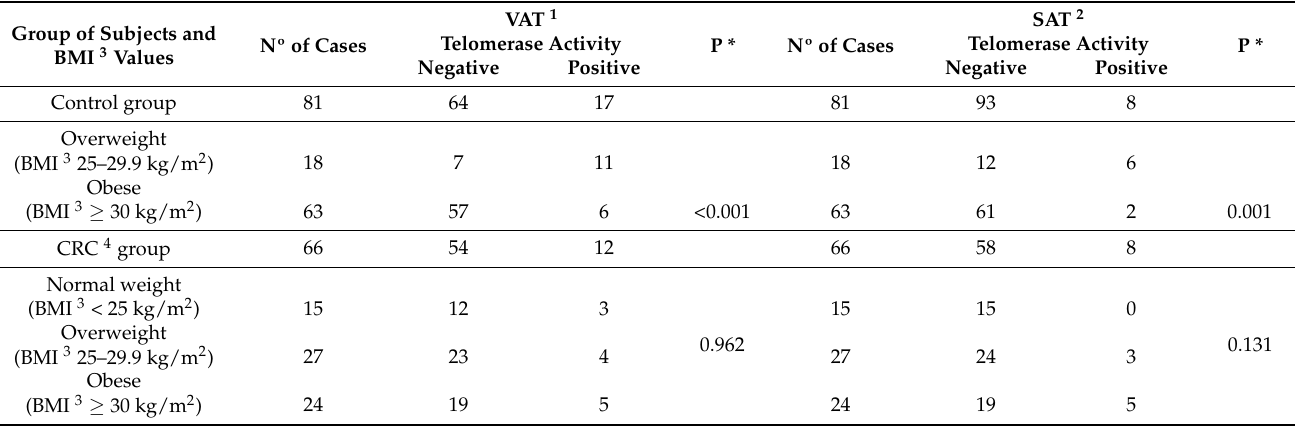
Table 4. Telomerase activity in visceral and subcutaneous adipose tissues from subjects without cancer (control group) and patients affected by colorectal cancer in relation to the body mass